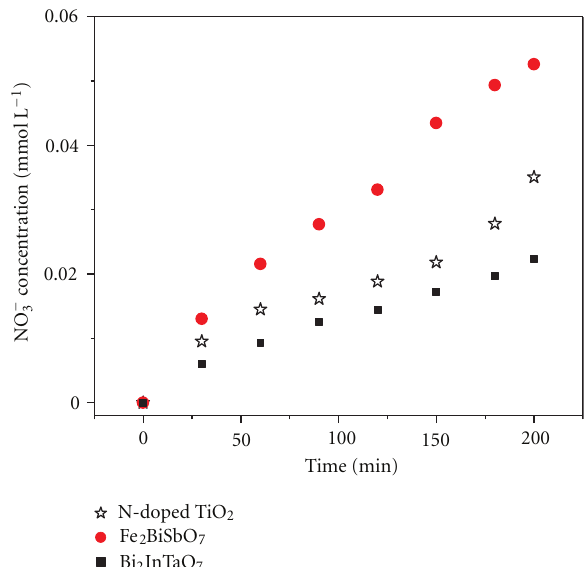
Figure 8: The concentration variation of NO 3 − during photocat- alytic degradation of methylene blue with Fe 2 BiSbO 7 , Bi 2 InTaO 7 , or N-doped TiO 2 as catalyst under visible light